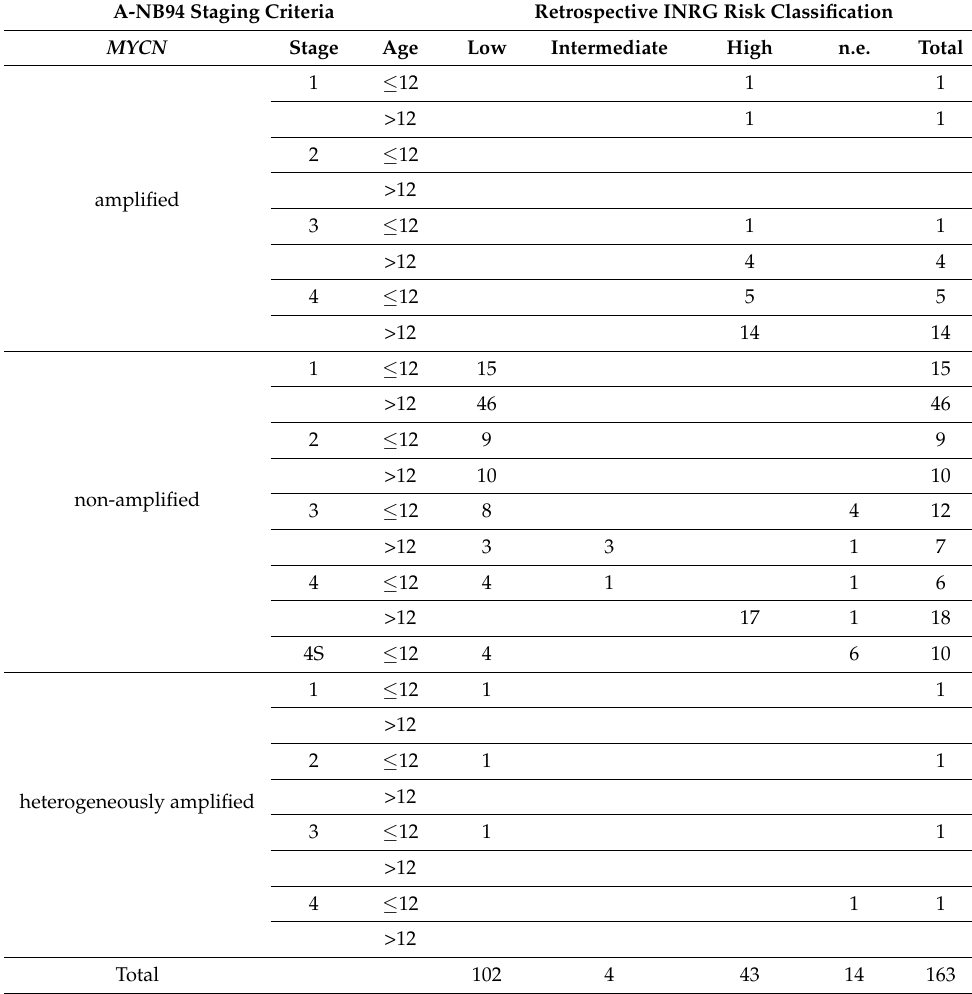
Table A1. Retrospective correlation of A-NB94 risk groups with INRG stratification.